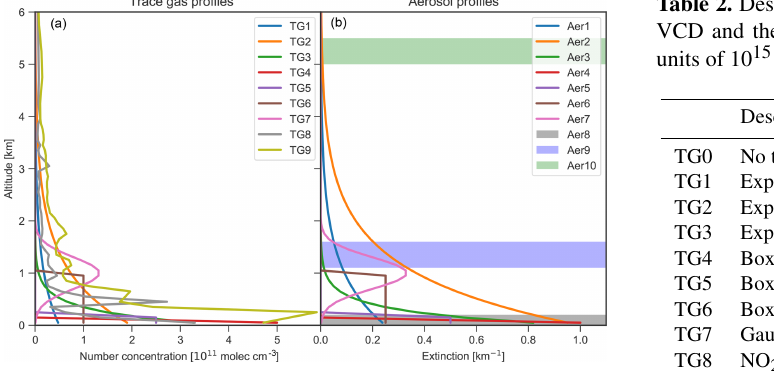
Figure 2. Trace gas number concentration (a) and aerosol extinction (b) vertical profiles as input for the forward modelling of HCHO, NO 2 , and O 4 . The shaded areas in (b) indicate the location of fog and cloud layers with an extinction coefficient of 10km − 1 . The properties of the individual profiles are described in Tables 2 and 3.